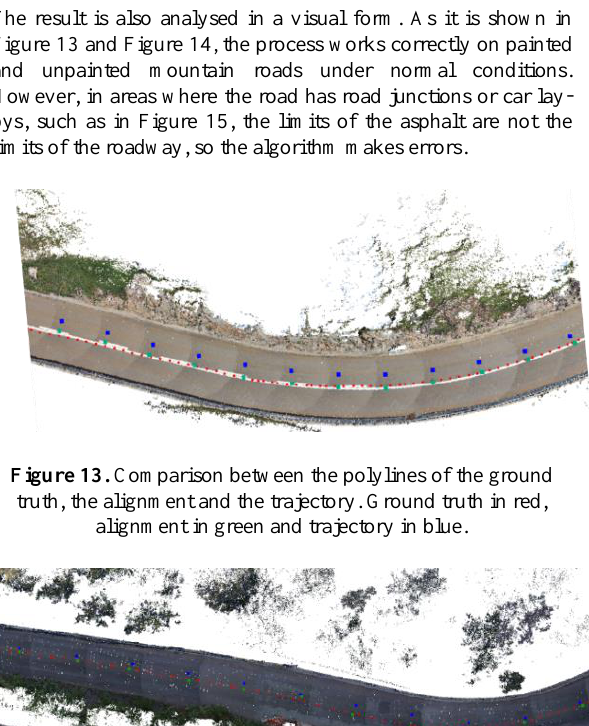
Figure 12. Histogram of the distances between each alignment point and the ground truth.